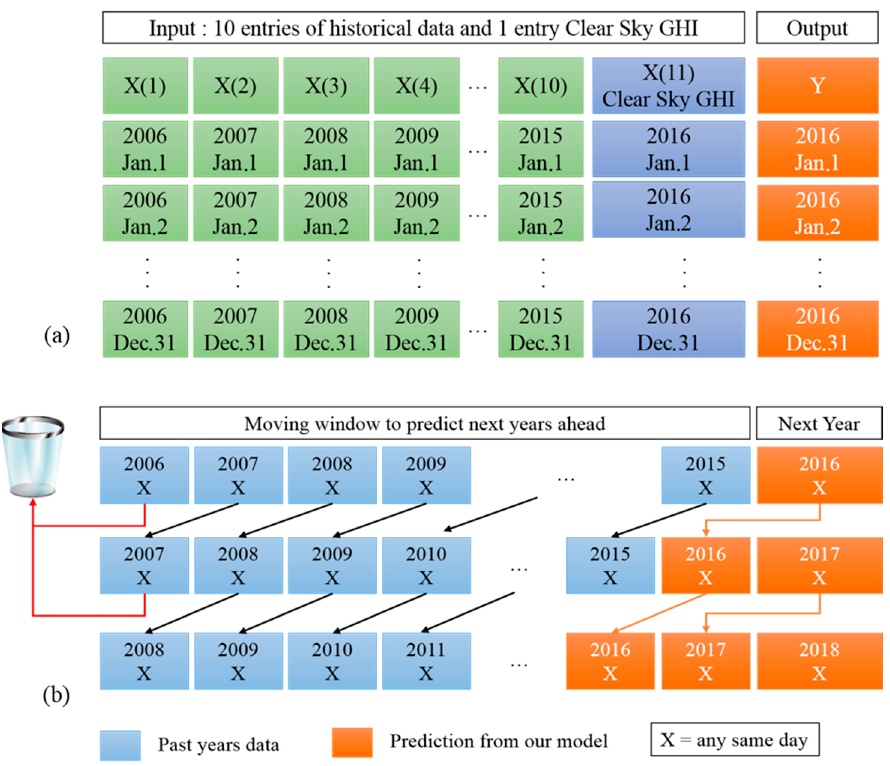
Figure 4. Proposed data management and processing to train deep learning models. ( a ) One year ahead prediction. ( b ) Multiple years ahead predictions.